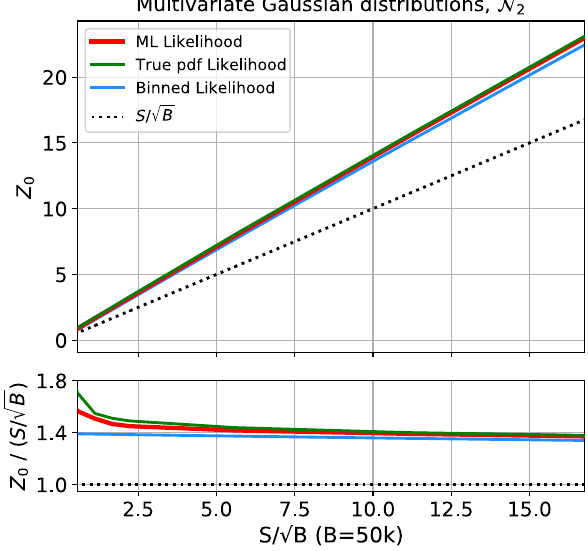
Fig. 3 Discovery significance calculated with various methods for the example in Fig. 2 for fixed background, (cid:8) B (cid:9) = 50k, and different signal strengths (cid:8) S (cid:9) . Red lines show the results implementing the ML Likeli- hood method with XGBoost used to estimate the probability density for single events and green lines when using the true multivariate distri- butions. The black dotted line represents the result of the usual counting √ B , in the entire range of interest (only one bin), and the method, S / light blue curve the result of a binned counting